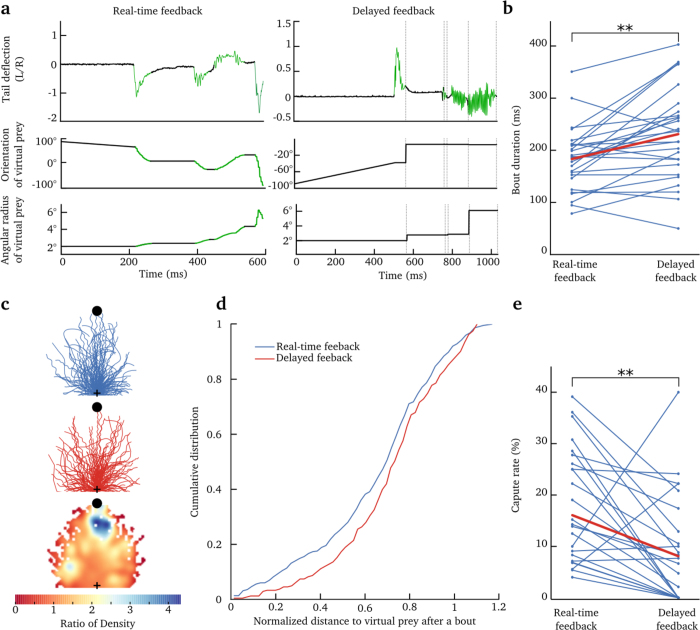
Delayed visual feedback affects prey-capture behavior.(a) Tail deflection of the larva and the corresponding modification of the virtual-prey position (visual feedback): angular position and size of the virtual prey. Left panel: feedback was continuously updated during tail movements (green). Right panel: the feedback was delayed and presented only after the end of the bout (the time indicated by the vertical dashed lines). The green segments on all curves indicate the detection of tail bouts and the corresponding modification in size and position of the virtual prey. (b) Average duration of bouts in real-time and delayed feedback conditions, for each larva. The average is shown in red. (p = 0.0012, Wilcoxon signed-rank test). (c) Normalized bouts: the paths of each bout was rotated and rescaled according to the position of the virtual prey (black dot). The starting position is indicated by the black cross. Upper panel: normalized bouts for all larvae when the feedback was presented in real time. Middle panel: normalized bouts of all larvae, when the feedback was presented at the end of a bout (delayed feedback). Lower panel: ratio of the density of normalized bouts. The color bar indicates the ratio of density between the real-time and delayed feedback conditions (>1 indicates that the density of paths is larger for the real-time with respect to the delayed feedback) (d) Cumulative distribution of the normalized distance to the virtual prey at the end each bout, for trials in which the feedback was provided in real time (blue) or after the end of the bout (red). The distribution were significantly different (p = 0.04, Kolmogorov-Smirnov test). A normalized distance of 0.5 means that the bouts reduced the distance to the prey by half. (e) Percentage of trials that ended in a successful capture of the virtual prey, for real-time feedback (left), and delayed feedback trials (right) (from 27 larvae). The red segment depicts the average.